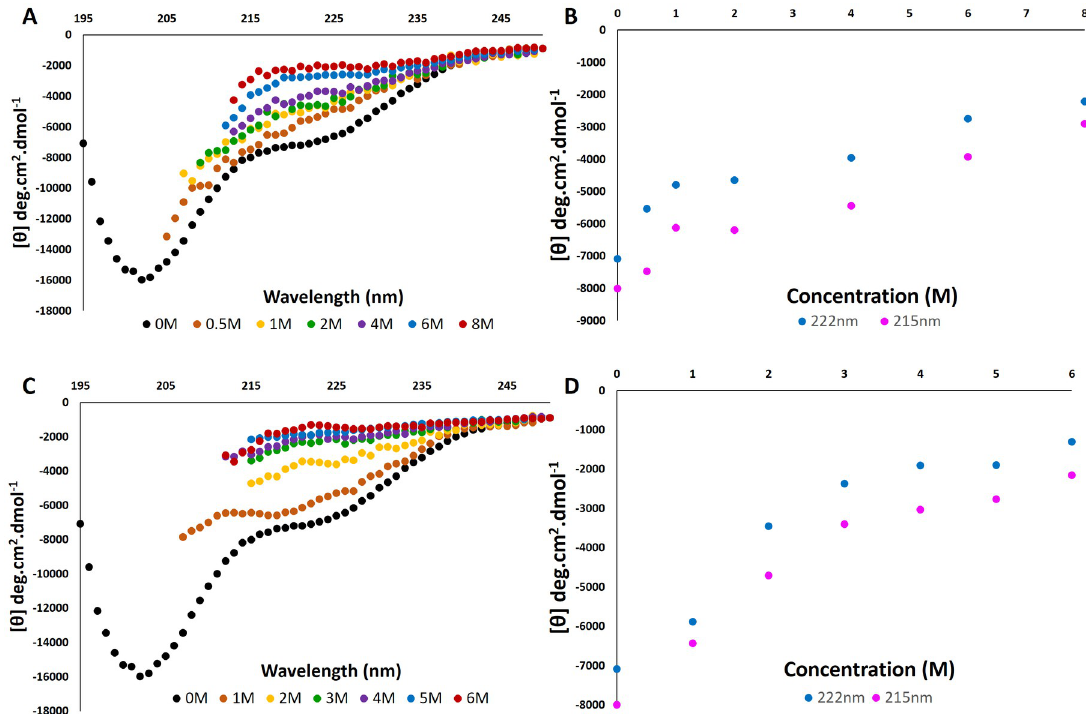
Fig 8. RBBP6 p53BD in the presence of denaturants. (A) : Far-UV CD Spectra between 250 nm and 195 nm for the RBBP6-p53BD from 0 to 8 M urea (B) : Far UV-CD curves at 215 nm and 222 nm for 0 to 8 M urea. (C) : Far-UV CD Spectra between 250 nm and 195 nm for the RBBP6-p53BD from 0 to 6M guanidinium chloride. (D) : Far UV-CD curves at 215 nm and 22 2nm for 0 to 6 M guanidinium chloride.